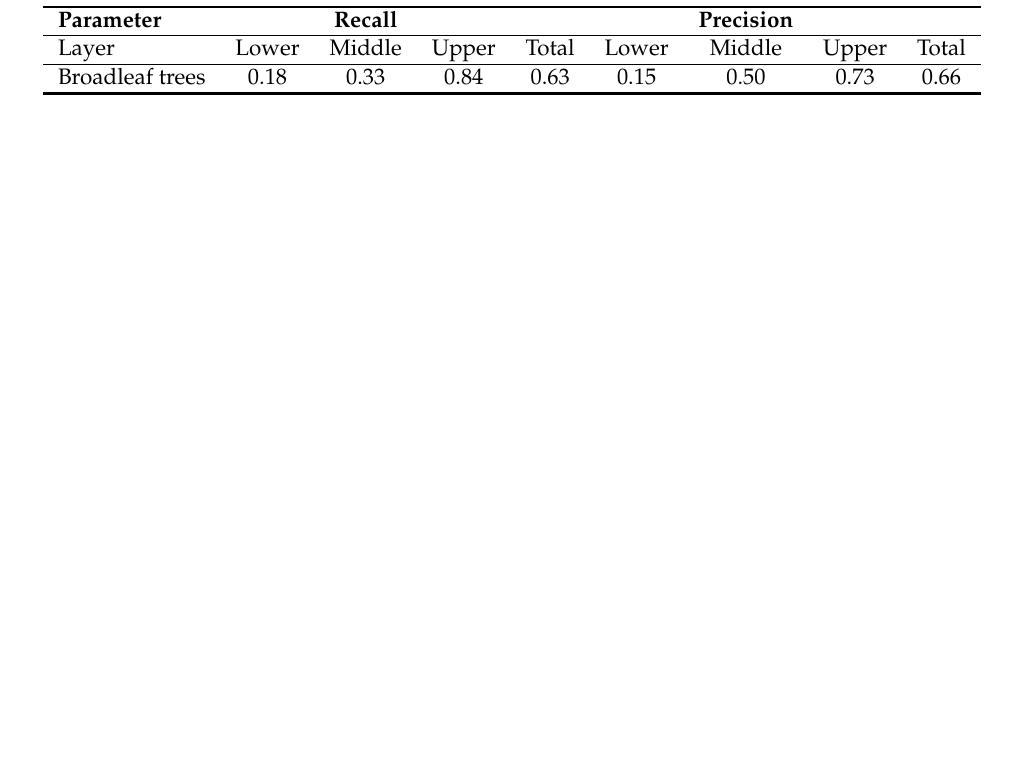
Table 11. Sensitivity analysis of tree detection regarding conifers and broadleaf trees. The reference area is HTO . Control parameter NCut = 0.10. Total number of trees is